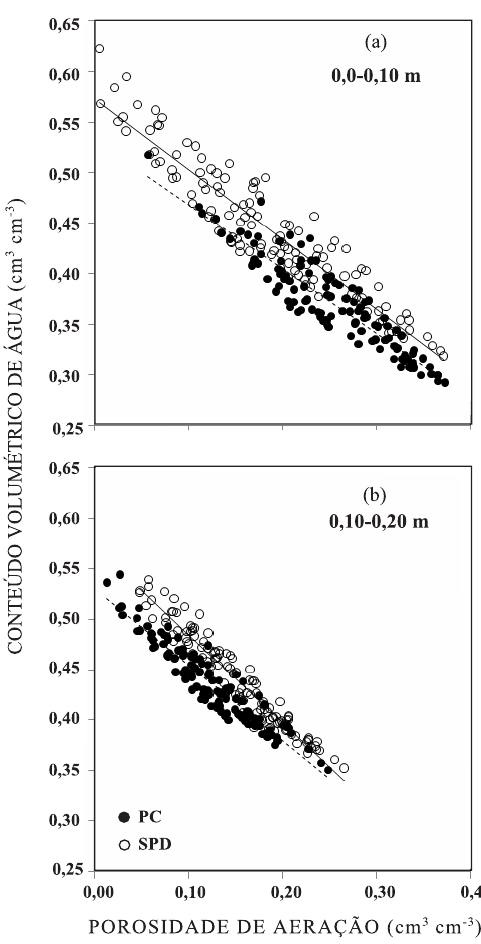
Figura 2. Porosidade de aeração ( εεεεε ) em função do a conteúdo volumétrico de água ( θθθθθ ) nos potenciais de -2, -6, -10, -30, -70 e -100 kPa em um Latossolo Vermelho distrófico sob preparo convencional (PC) e sistema plantio direto (SPD), nas profundidades de 0–0,10 e 0,10–0,20